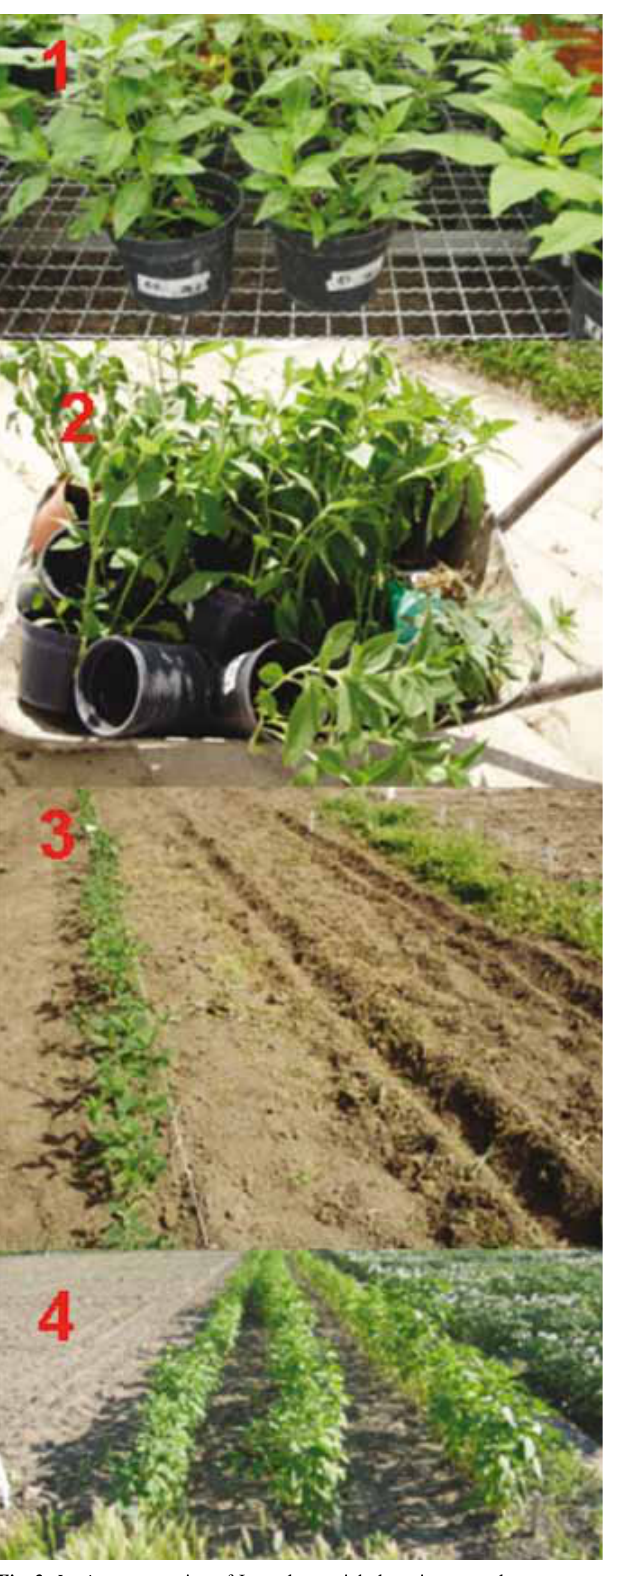
Fig. 2: In vivo propagation of Jerusalem artichoke using transplants: cultivated tubers in pots in green house (photo 1); produced transplants ready for cultivation (photo 2); cultivated transplants in the field (photos 3 and 4) (Photos by N. Abd Alla, Demonstration Garden, Agricultural Botanics, Plant Physiology and Biotechnology Dept., Debrecen Uni., Hungary, 2013-2014)